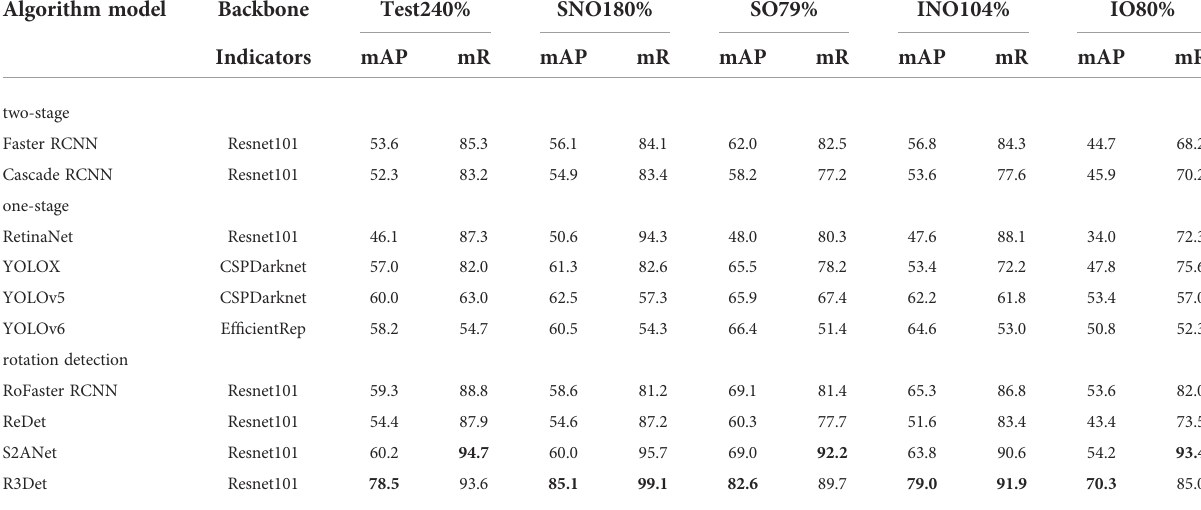
The bold numbers in the table indicate the highest values of he experimental